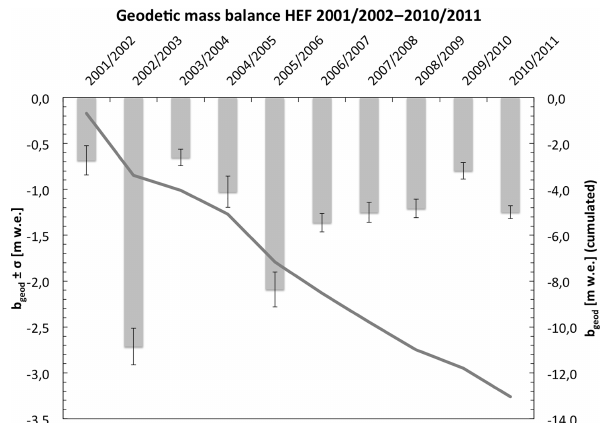
Figure 8. Available geodetic mass balances b geod ± σ [mw.e.] for Hintereisferner from 2001–2011 and the cumulated balance 2001– 2011 ( b geod cumulated) as derived from airborne laser scanning measurements (Klug et al., 2017; see also Sect.